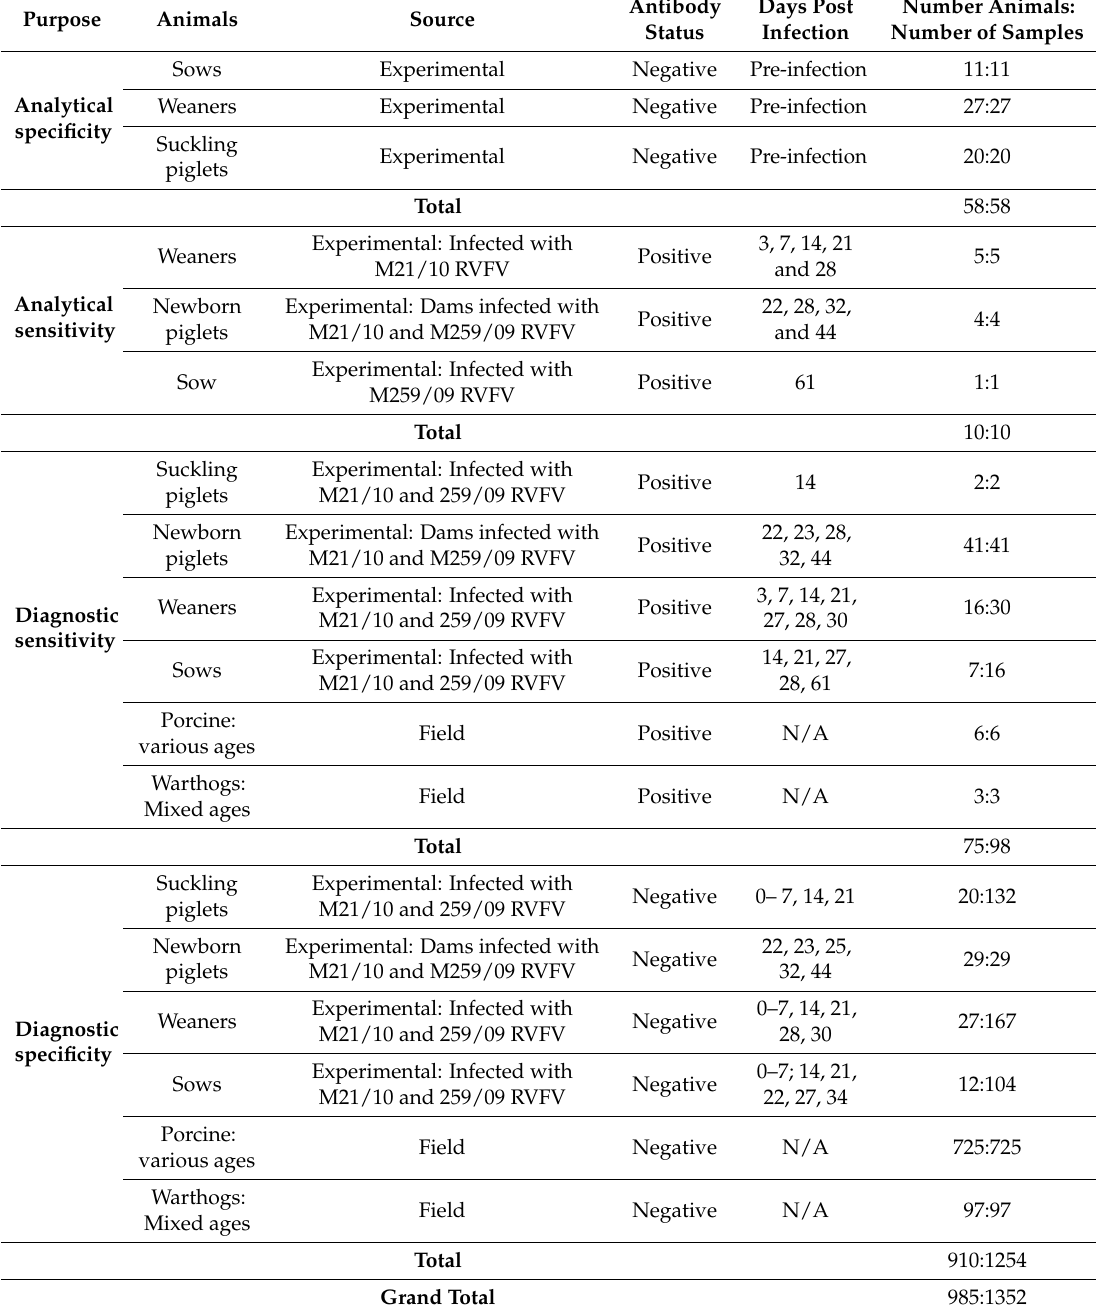
Table 1. Experimental and field samples categorised as positive and negative by the competition ELISA and used in the evaluation of the virus neutralisation test (VNT). The samples used for determination of analytical performance were included in sessing assay diagnostic